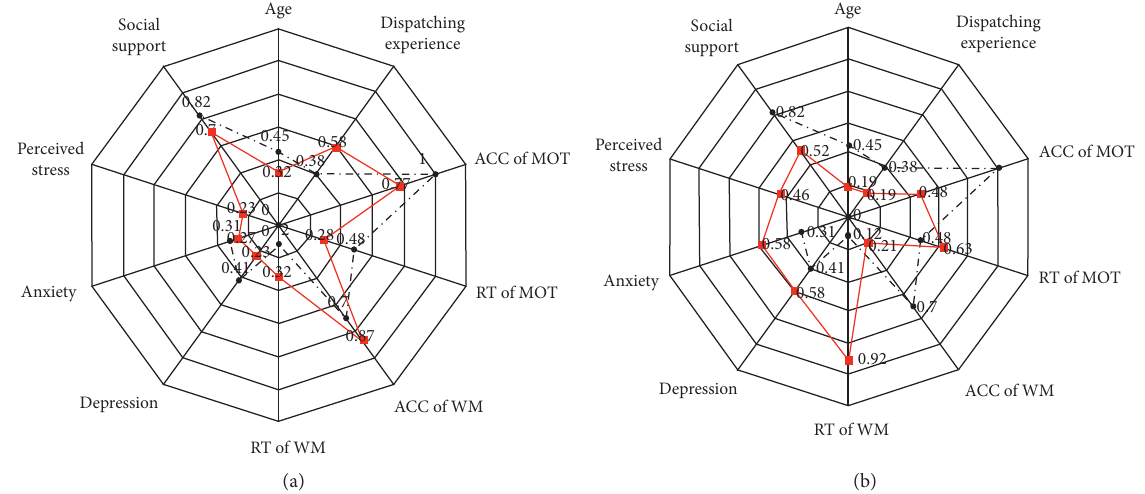
Figure 8: The results of mean of each variable of Good and Poor and the number